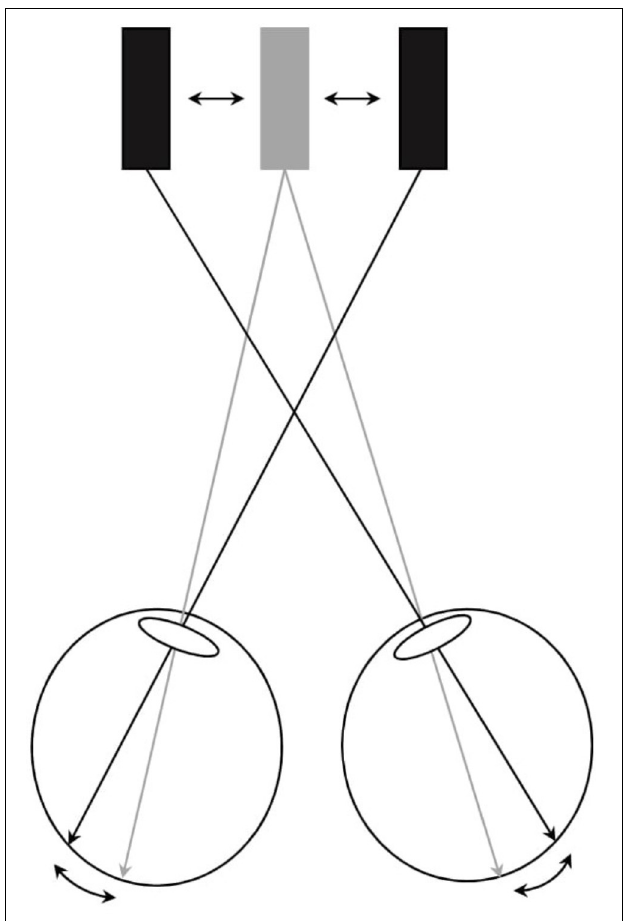
FIGURE 1 | Visualization of stimulus to convergence during conflicting stimulus-to-accommodation and stimulus-to-vergence eye-movements. Participants fixated upon the bar presented separately to the left and right eyes through polarized filters. A computer setup was used that enabled horizontal vergence load to be induced dynamically. When convergence eye movements were stimulated, a conflicting stimulation to accommodation and vergence was induced since accommodation needs to be maintained at 1.54 diopters (i.e., the distance to the bar stimuli projected on the screen, illustrated by the grey stimulus bar) to see the bar clearly, and not to the corresponding distance of the vergence angle of the eyes (illustrated by the black bars). By increasing the horizontal distance between the two images (black bars), convergence was stimulated and by reducing the horizontal distance, divergence was stimulated. If subjects did not comply with the vergence stimulus change by producing compensatory divergence/vergence eye movements, then diplopia resulted.